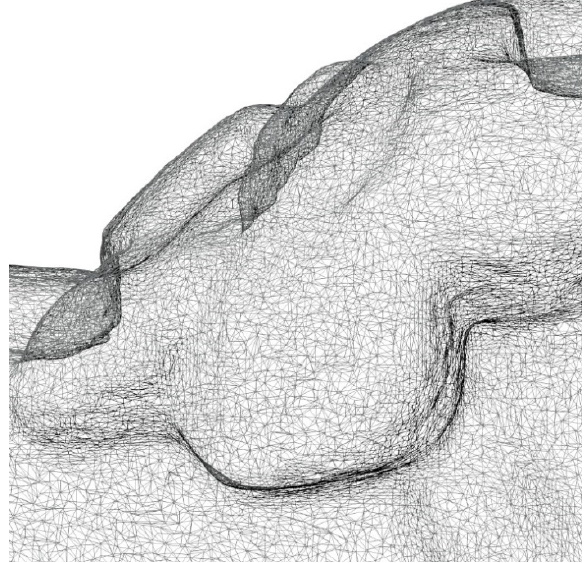
Figure 3. A 3D model of a rococo detail of the wooden chair